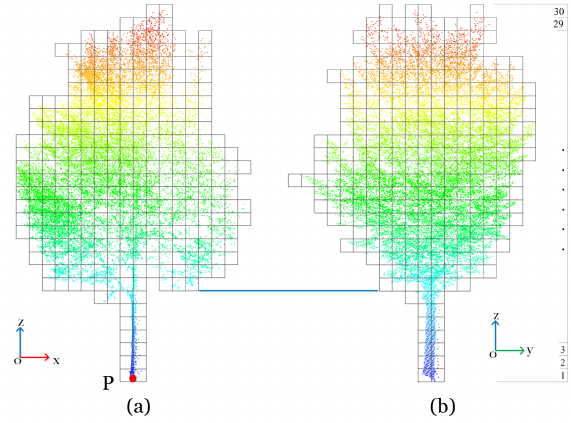
Figure 2: Strategy to estimate the location and trunk length of a